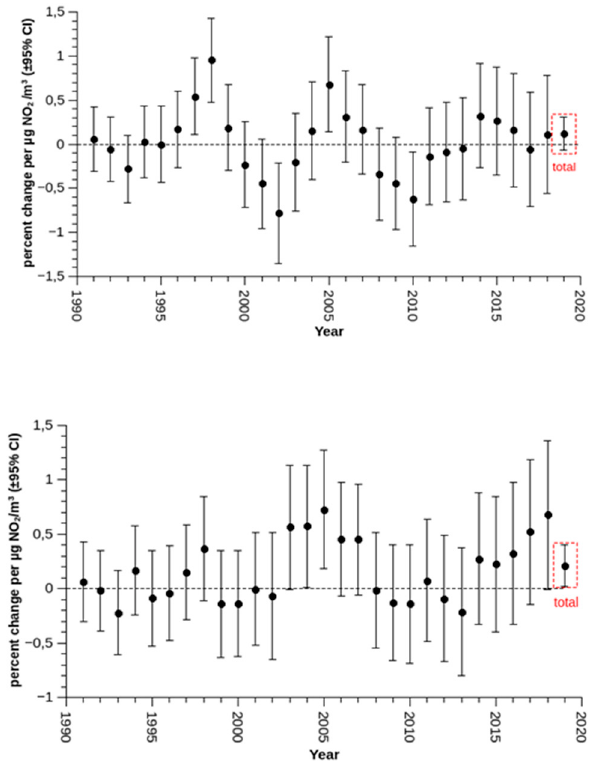
Figure 3. Top: E ff ect estimates (percent change of daily mortality per 10 µ g / m 3 increase in NO 2 ) of Figure 3. Top: Effect estimates (percent change of daily mortality per 10 µg/m 3 increase in NO 2 ) of same day NO 2 (5 year sliding estimates until, Poisson model). Bottom: E ff ect estimates (percent change same day NO 2 (5 year sliding estimates until, Poisson model). Bottom: Effect estimates (percent in daily mortality per 10 µ g / m 3 increase in NO 2 ) of previous day NO 2 (5-year sliding estimates until, change in daily mortality per 10 µg/m 3 increase in NO 2 ) of previous day NO 2 (5-year sliding Poisson estimates until, Poisson model).